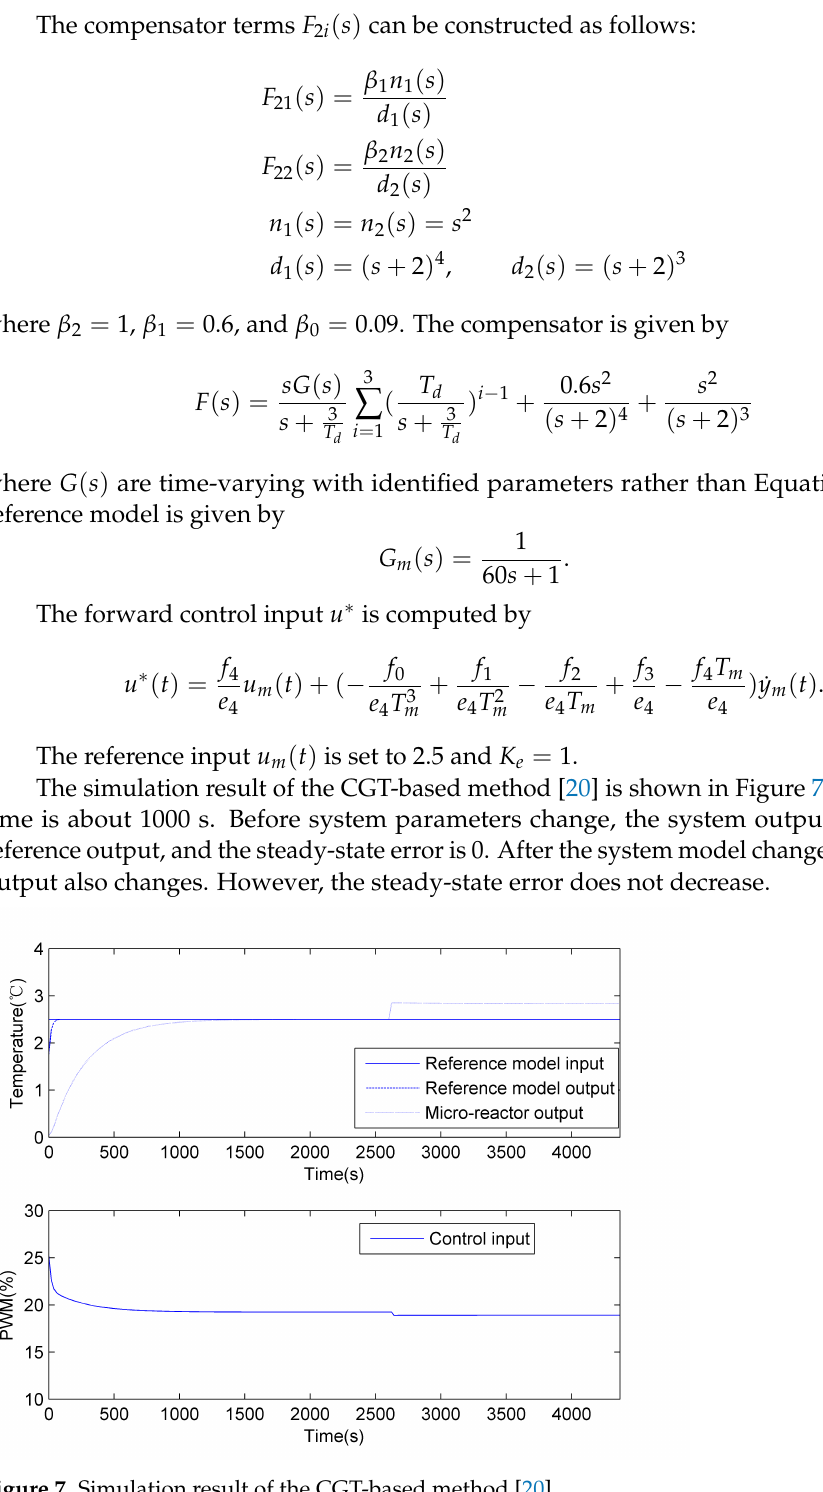
Figure 7. Simulation result of the CGT-based method